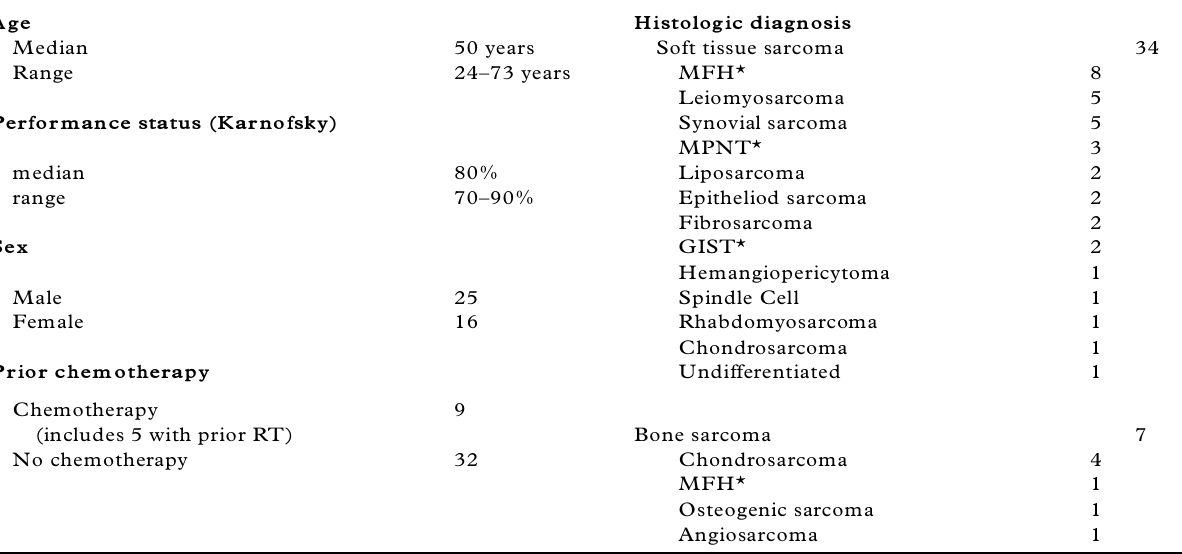
Table 1. Characteristics of 41 patients treated with ifosfamide + G-CSF =/±